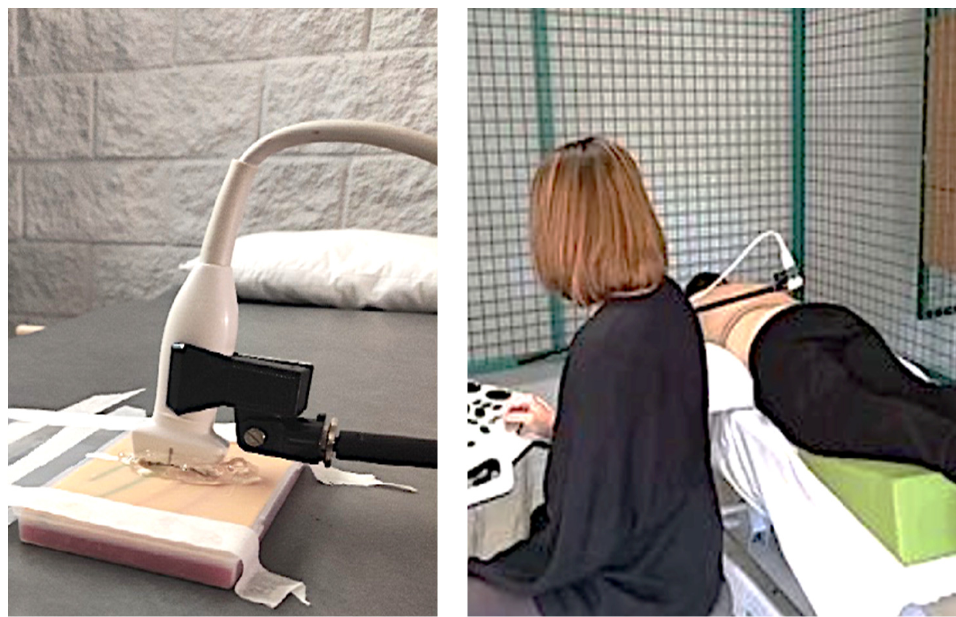
Figure 1. Phantoms and Patients sampling. A Phantom (AliExpress ‐ Toperfect Teaching Model&Toll Store model CNY 131.54)